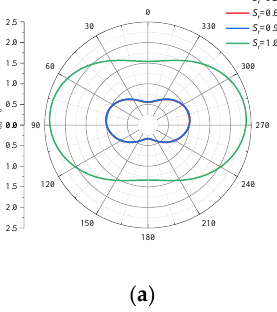
Figure 2. Effects of saturation on distributions of σ S incidence with the second set of parameters in Table 1 with υ = 0.3 for an impermeable boundary. ( a ) k 0 a = 0.5. ( b ) k 0 a = 1.0. ( c ) k 0 a =